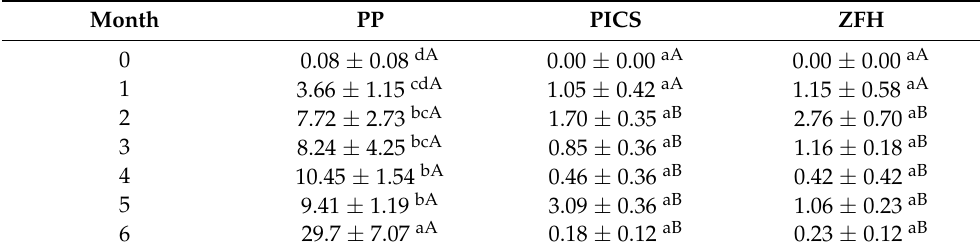
Table 4. Mean ( ± SE) weight loss (%) of maize from Polypropylene (PP), Purdue Improved Crop Storage (PICS), and ZeroFly ® Hermetic (ZFH) bags sampled during the months of October 2020– March 2021.